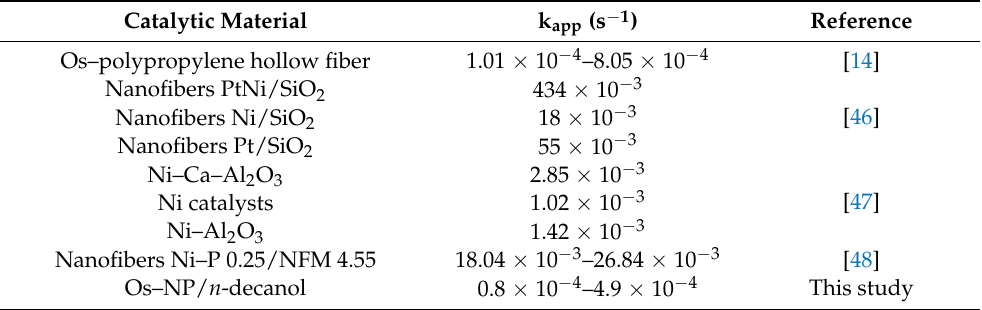
Table 1. Comparative data of the ‘apparent catalytic rate constant ( k app )’ for the catalytic reduc- tion processes.